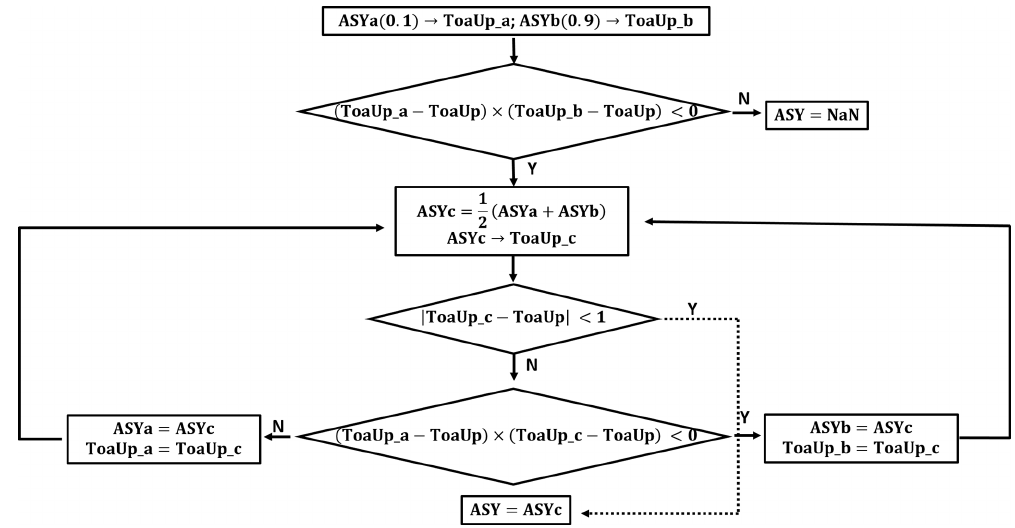
Figure 4. A detailed workflow of the binary search used in ASY